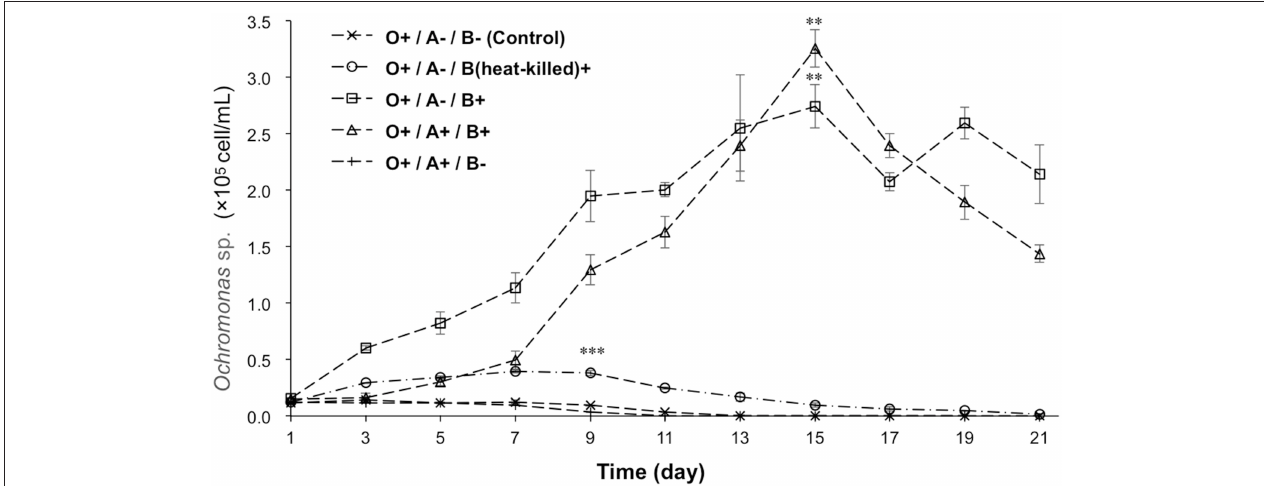
FIGURE 3 | The growth curves of Ochromonas sp. under the effects of bacteria and A. tamarense . “A” indicates A. tamarense ; “O” indicates Ochromonas sp.; “B” indicates bacteria; “ + ” indicates present; “ − ” indicates absent. The asterisks ** , and *** denoted statistical significance with p -values less than 0.01, and 0.001, respectively. All error bars indicate the SE of the three biological replicates.